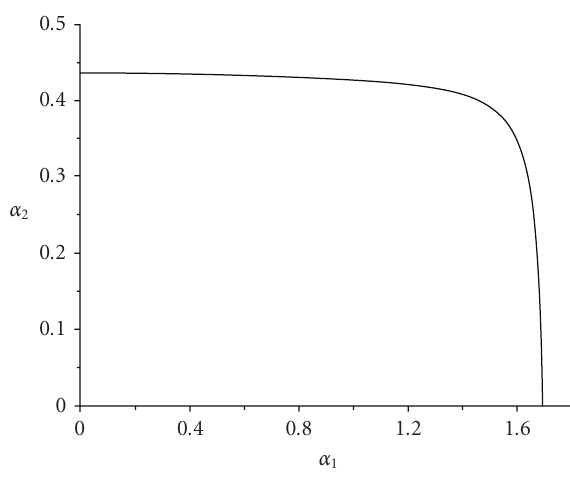
Figure 3.1 . Stability region of Nash equilibrium.